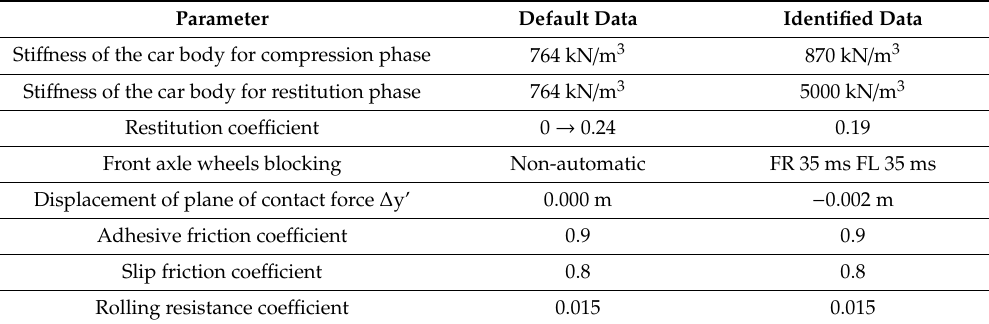
Table 1. Default and identified